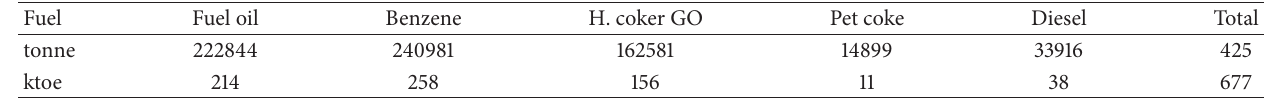
Table 16: Fuel demand for thermal electric power base year 2014 [9].